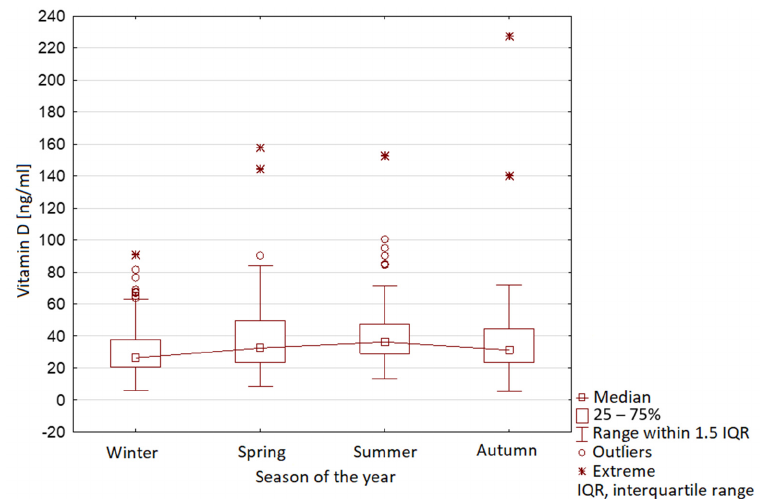
Figure 9. Vitamin D serum level range in year seasons in children before COVID-19 pandemic (Group 1).